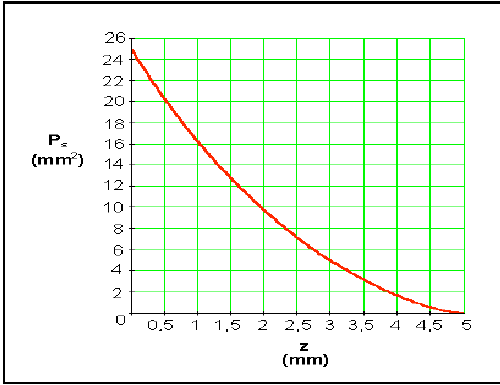
Fig. 9. Diagram P = f(z) for v